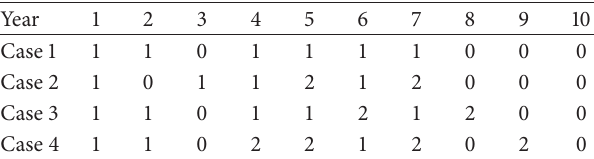
Table 17: Transmission lines construction distribution in the four cases.